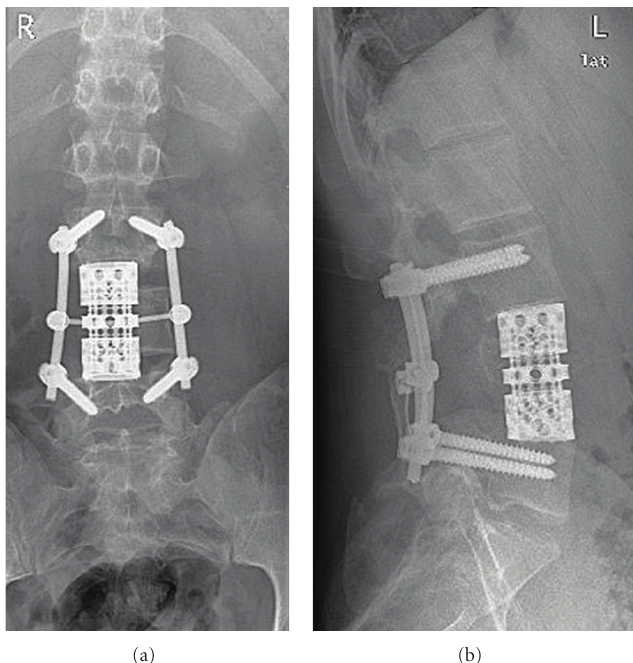
Figure 1: X-ray after dorsoventral spondylectomy. Postoperative X-ray of case 6. Dorsoventral intralesional spondylectomy of L4, dorsal instrumentation from L3 to L5, and titanium cage interposition with bone graft.